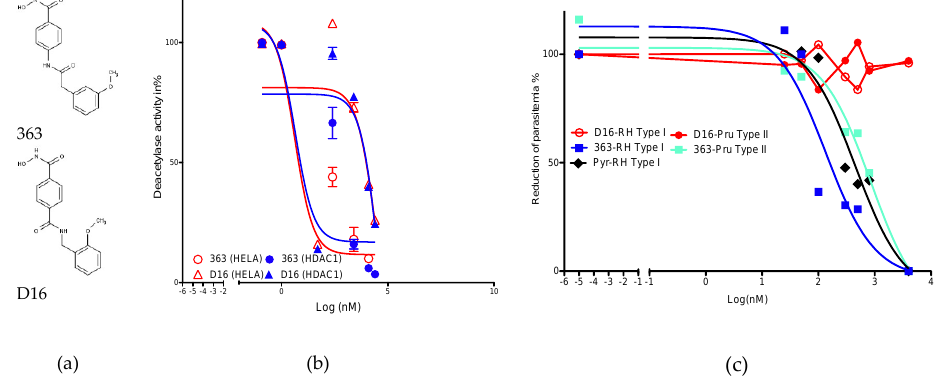
Figure 1. Hstone deacetylase inhibitor (HDACi) and anti- Toxoplasma gondii activity of the compounds. Structure of 363 and D16 ( a ), deacetylase inhibitory activity ( b ), and anti-parasitic activity against RH type I and Pru type II strains of T. gondii . Pyrimethamine (Pyr) was used as a positive control of inhibition ( c ). Results are representative of one experiment performed in